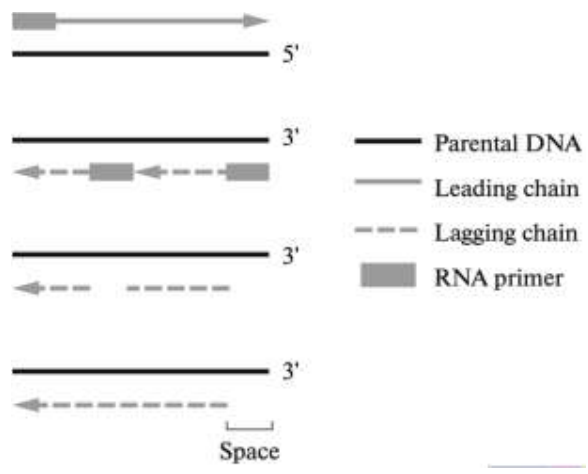
Figure 1. Problems associated with chromosomes’ terminal under -replication [2].